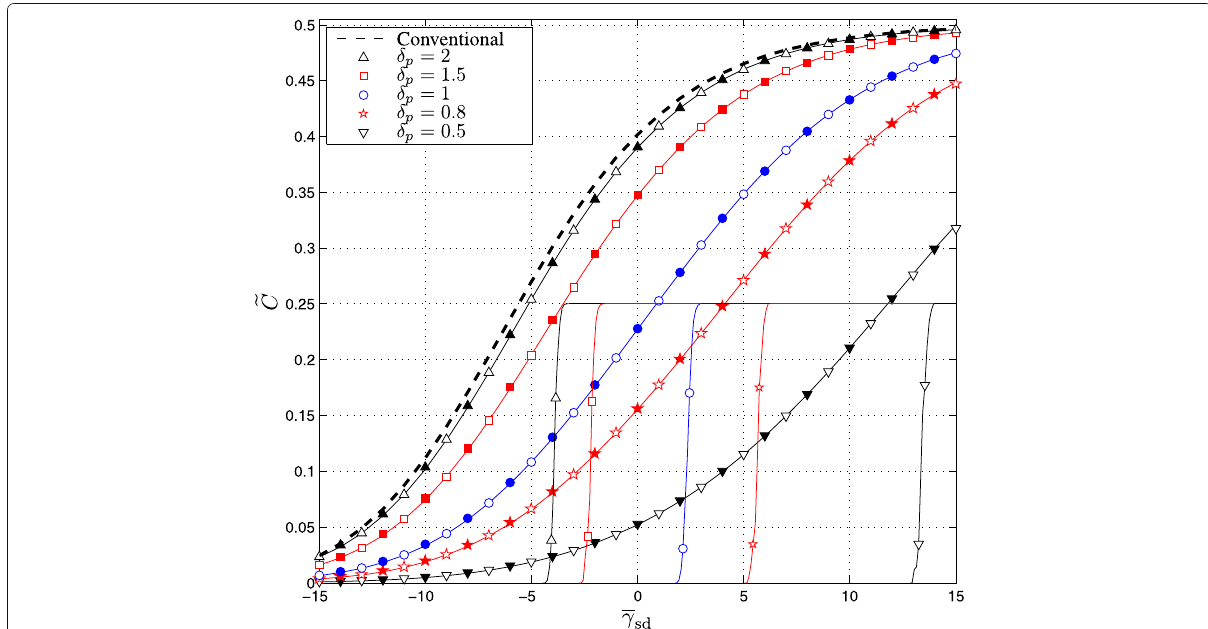
Fig. 2 Throughputs and BICM capacities of a two-hop cognitive relay channel as a function of γ sd , for different ratios δ p = d rp / d rd and fixed relay position δ r = 0 . 5 . For different ratios δ p = d rp / d rd , lines correspond to the analytical results, filled markers correspond to simulation results obtained using the exact L-values, and hollow markers correspond to simulation results obtained using the max-log approximation of L values ([9], Eq. (8)). The capacity of the conventional two-hop source-relay-destination link is shown as a reference (dashed line)